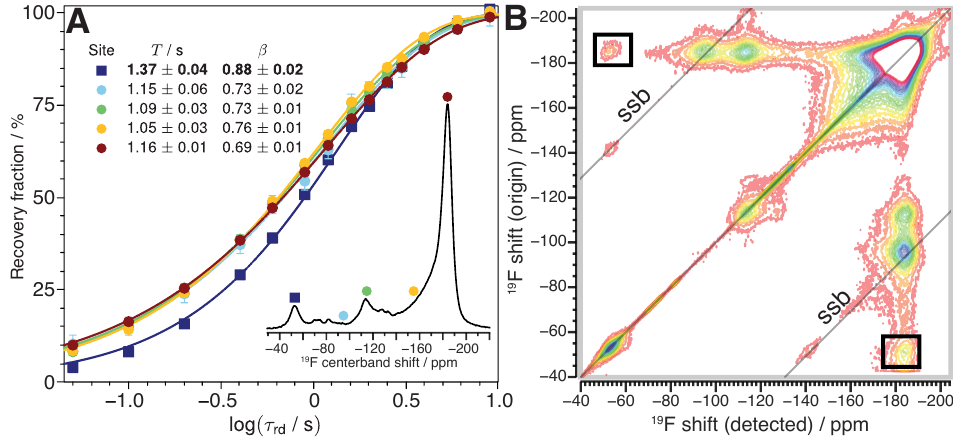
Figure 4. ( A ) Recovery of 19 F NMR signal from GF-1h773 as a function of delay τ rd after saturation of 19 F nuclear magnetization. Data points give the normalized intensity of NMR signal, S , for selected sites across the 19 F centerband line shape (inset spectrum). The sites correspond to ordered − > CF in (CF) n (red circles), disordered − > CF in (CF) n (yellow circles), >CF 2 (green circles), the low intensity region near -95 ppm (cyan circles), and hyperconjugated − > CF (blue squares). Error bars are plotted to the 2 σ level of spectral noise but usually remain smaller than the data markers. Curves are best fits of the data series to the stretched exponential recovery function S ( τ rd ) / S eq = 1 − exp The inset table gives parameters and asymptotic standard error from the best fit to S ( τ rd ) for each data series. ( B ) Two-dimensional { 19 F} 19 F EXSY spectrum from GF-1h773 using a longitudinal storage interval of 40 ms. Contours drawn from 8 σ noise level up to 12.5% of the 2D signal maximum. Diagonal grid lines mark secondary diagonals where spinning sidebands may contribute spectral intensity